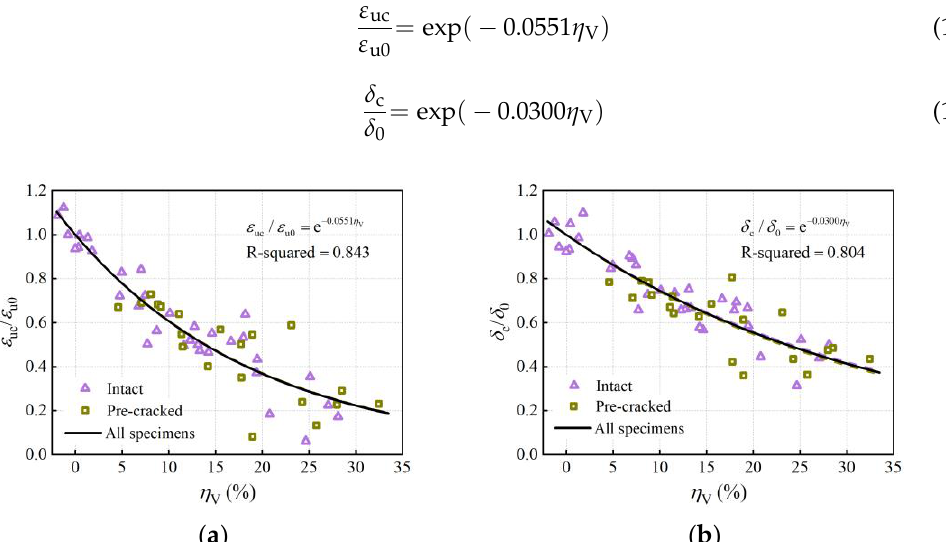
Figure 16. Effect of corrosion on ductility: ( a ) ultimate strain; ( b ) elongation after fracture.